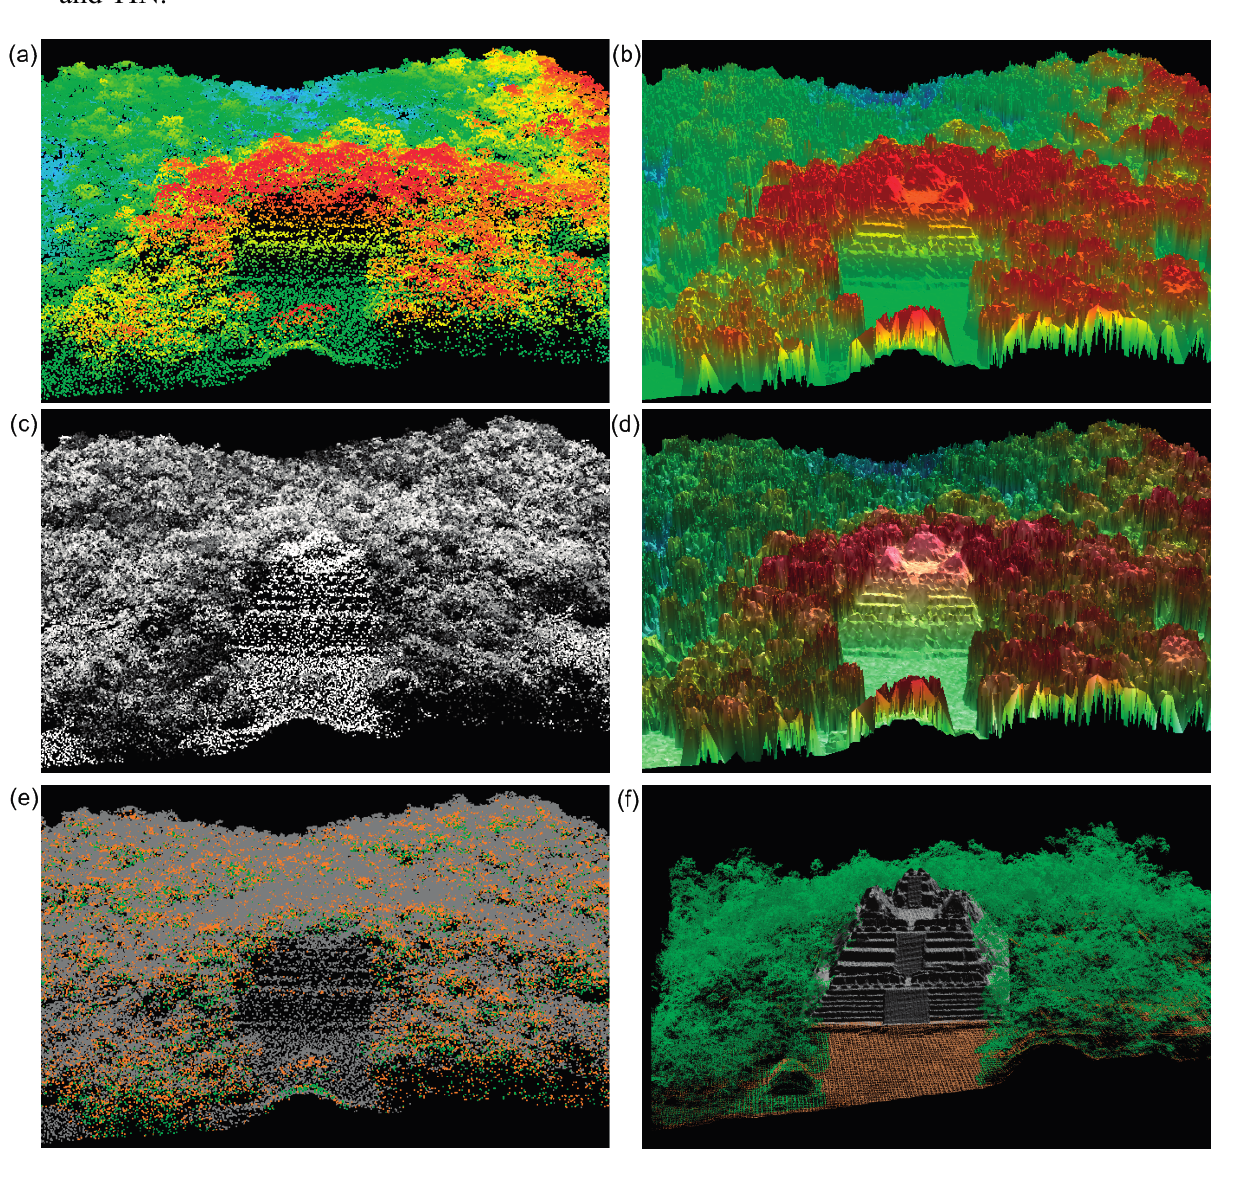
Figure 5. Visualization of the point cloud (PC) ( a ) PC colored by elevation; ( b ) triangulated irregular network (TIN) colored by elevation; ( c ) PC colored by return intensity; ( d ) TIN colored by elevation and intensity; ( e ) PC colored by class; ( f ) hybrid PC and